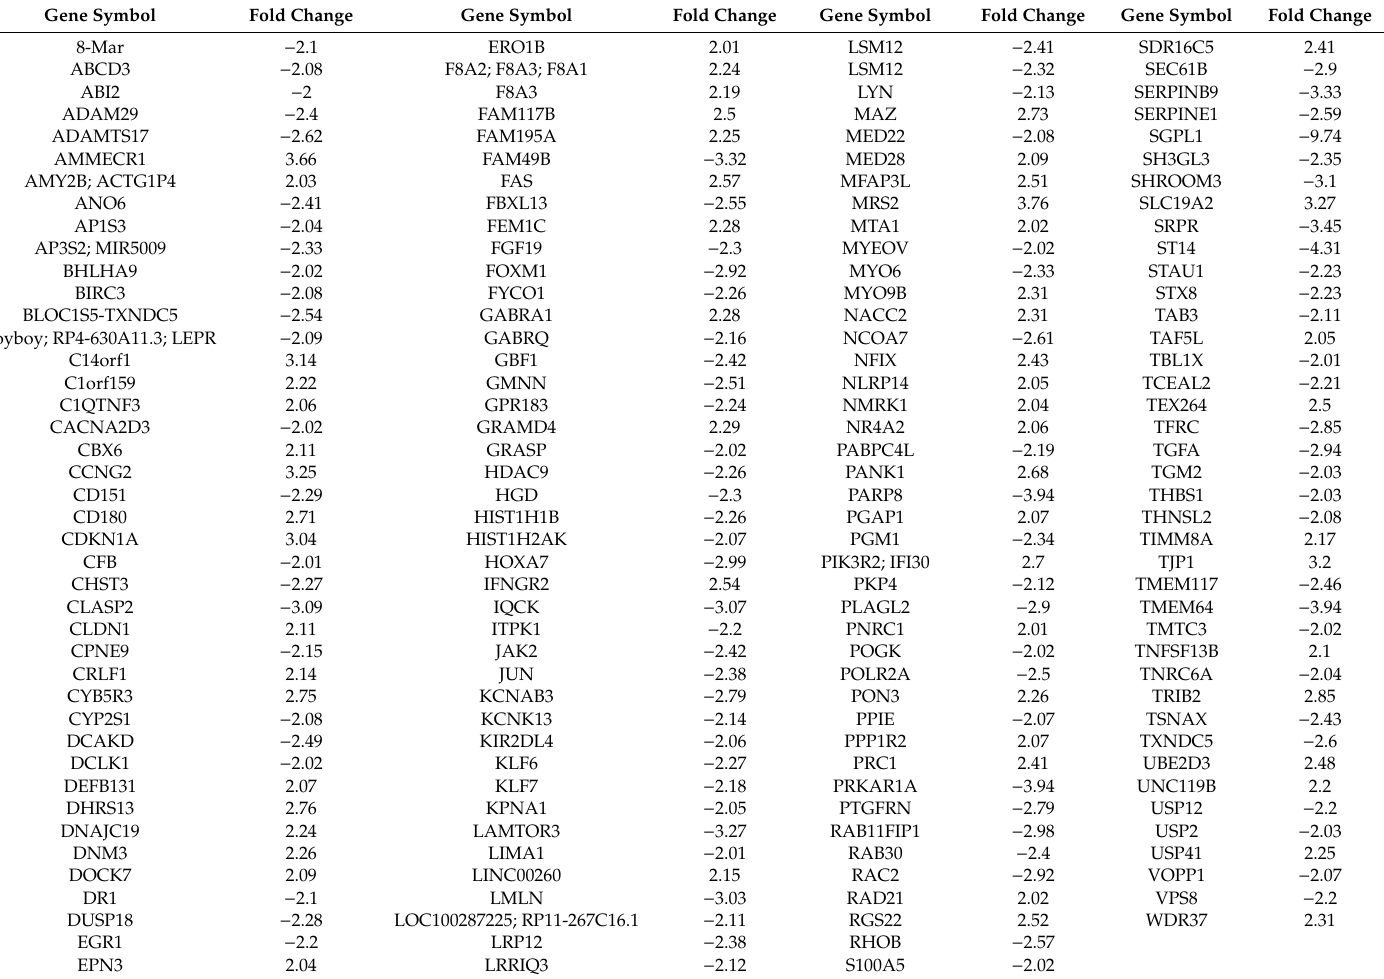
Table 2. List of mRNA selected by cDNA array analysis in SGPL1-downregulated